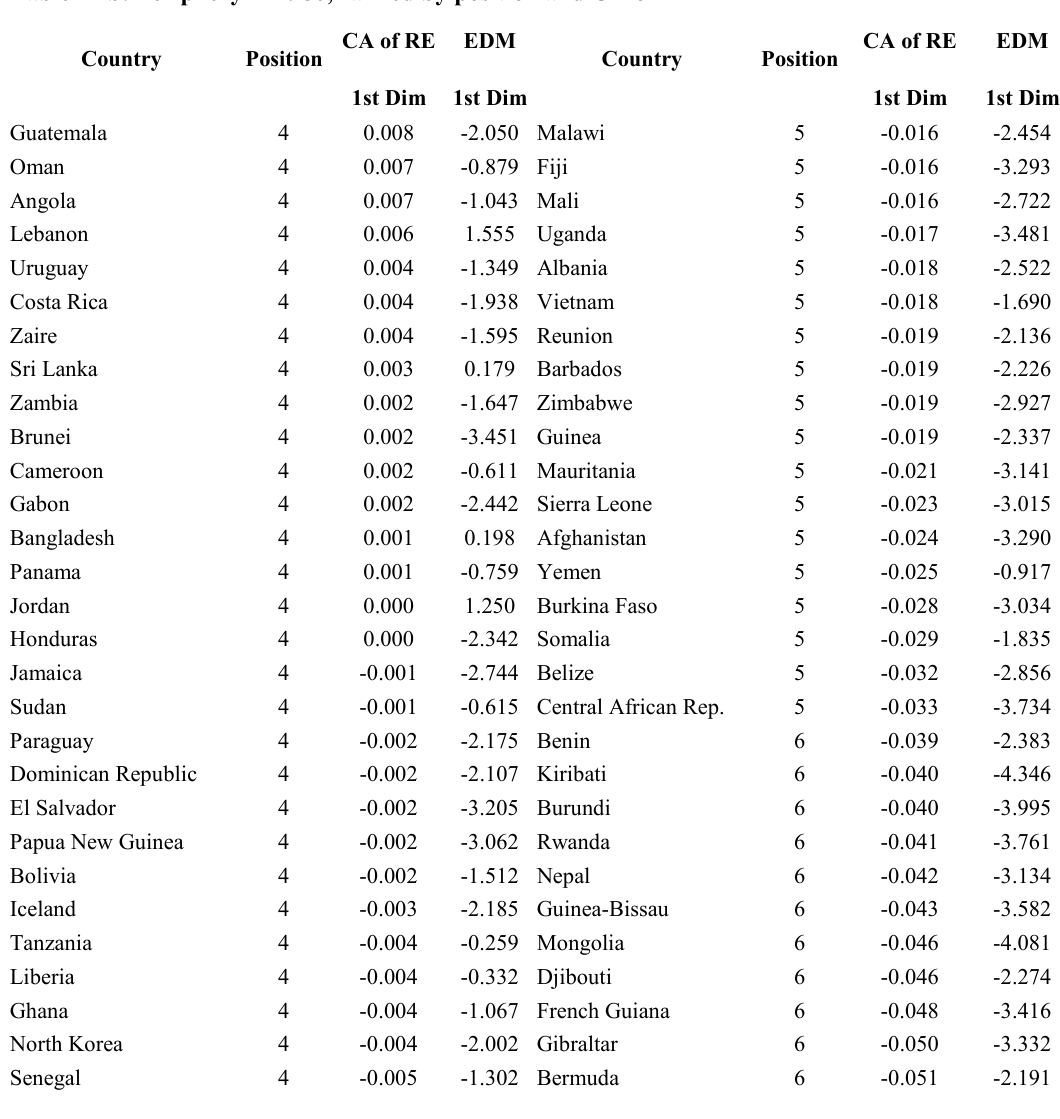
Table A1b: Periphery in 1980, ranked by position and CA of